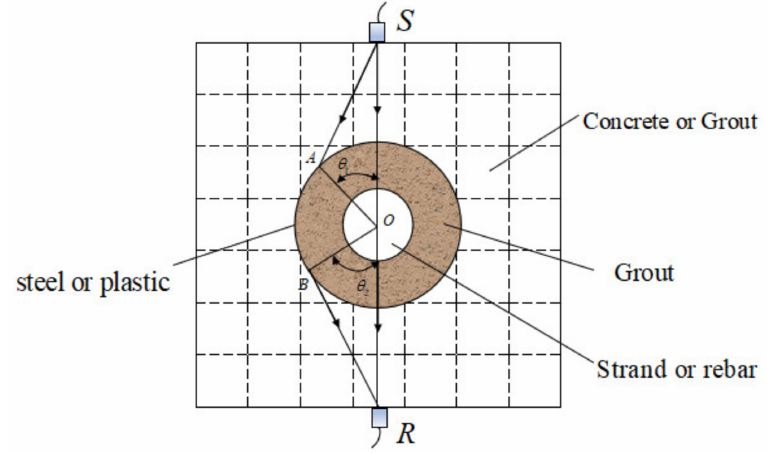
Figure 7. Theoretical